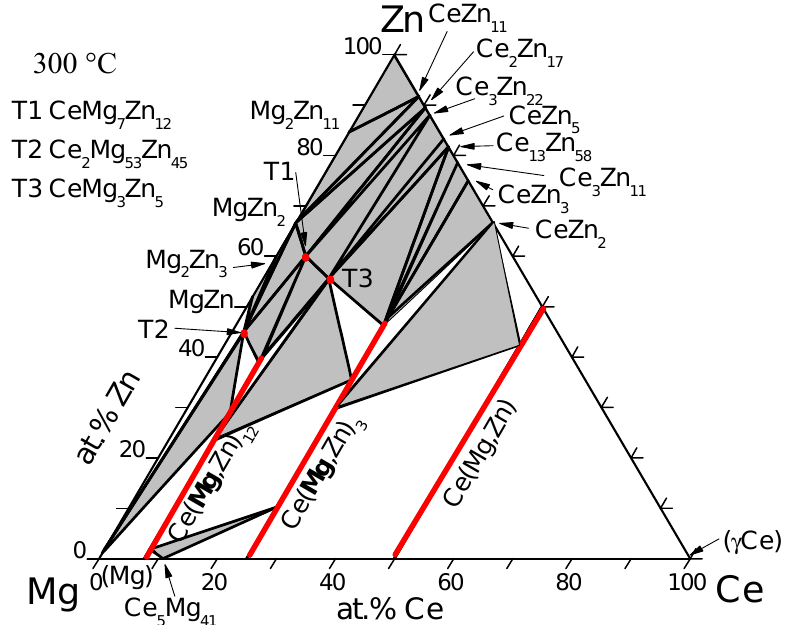
Figure 5. Calculated isothermal Mg-Ce-Zn phase diagram at 300 °C highlighting intermetallic phases with continuous (1) or limited (2) ternary solubility, and additionally three ternary stoichiometric phases